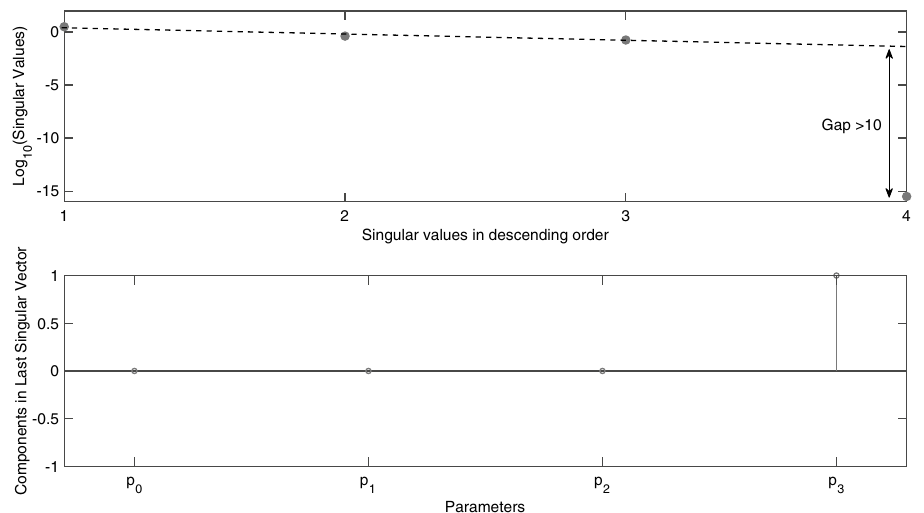
Figure 2. Identifiability signature of the benchmark model with input ( M 2 ). (Top) Singular values: When state x 1 is measured and x 2 ( 0 ) = p 1 / p 3 , the clear gap between the third and fourth singular values suggests rank deficiency of the sensitivity matrix. (Bottom) Entries in the last column of the right singular matrix: The nonzero entry corresponding to p 3 indicates that parameter p 3 is structurally